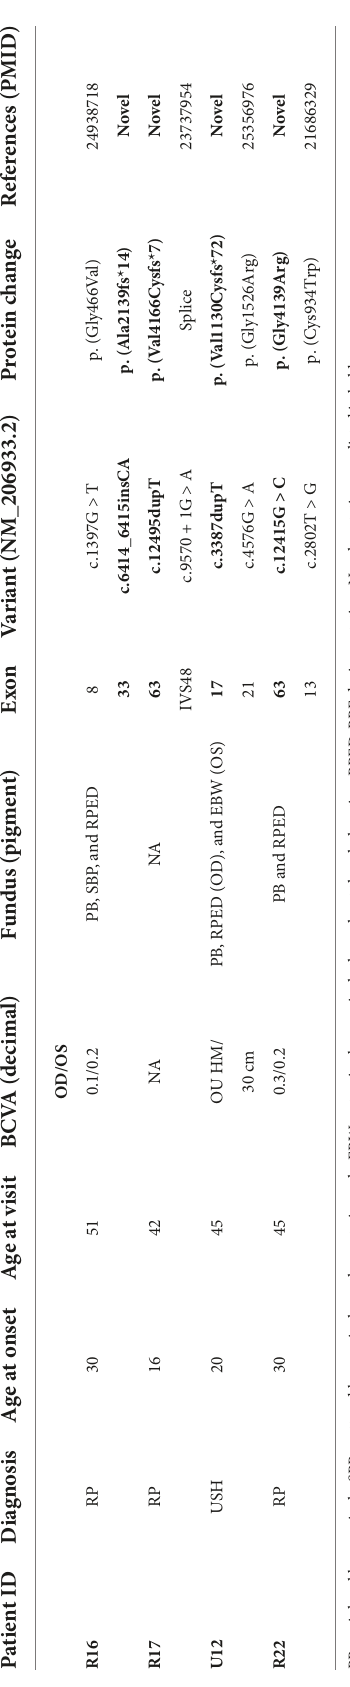
groups of different disease duration, the proportion of patients